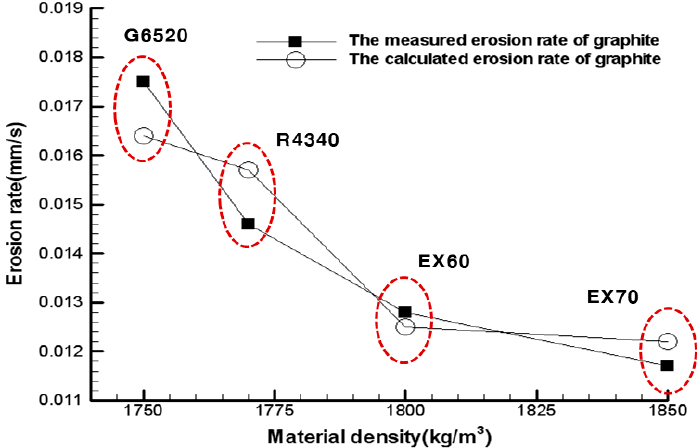
Figure 11. Comparison of measured and calculated erosion rates in terms of the density of graphite.